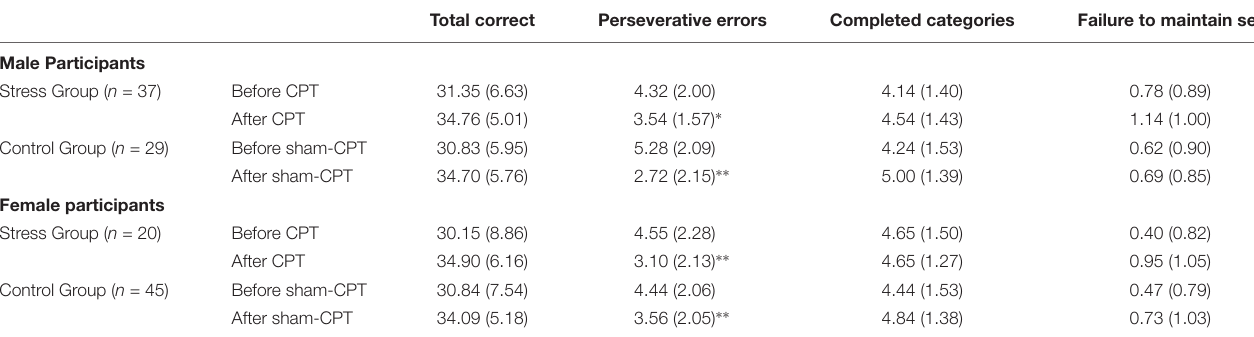
TABLE 1 | Means and SDs (in parentheses) of the outcome measures of executive functions on the Wisconsin Card Sorting Test as a function of Condition (Stress vs. Control) for Study 1. Total correct Perseverative errors Completed